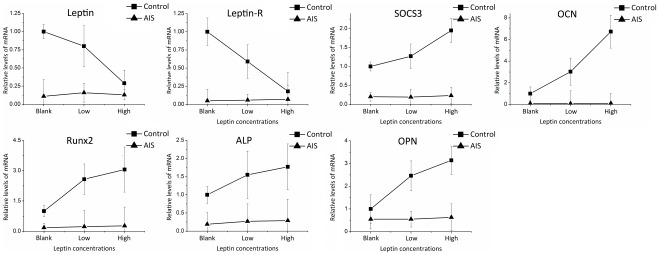
Gene expression levels in response to different doses of leptin.The expression levels in control group without leptin treatment were used as calibrators. Relative expression levels were calculated by using the 2−ΔΔCt method.